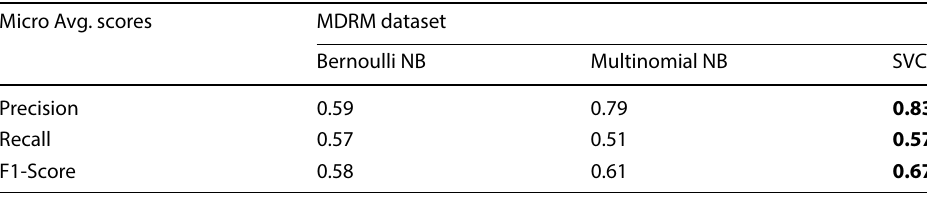
Table 3 Comparison of multiclass classification methods using original